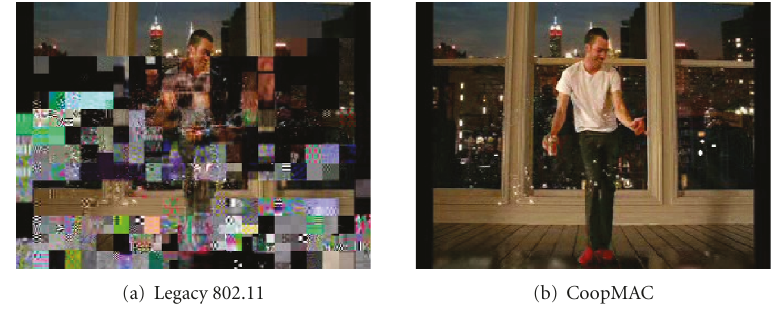
Figure 15: Video quality comparison: a